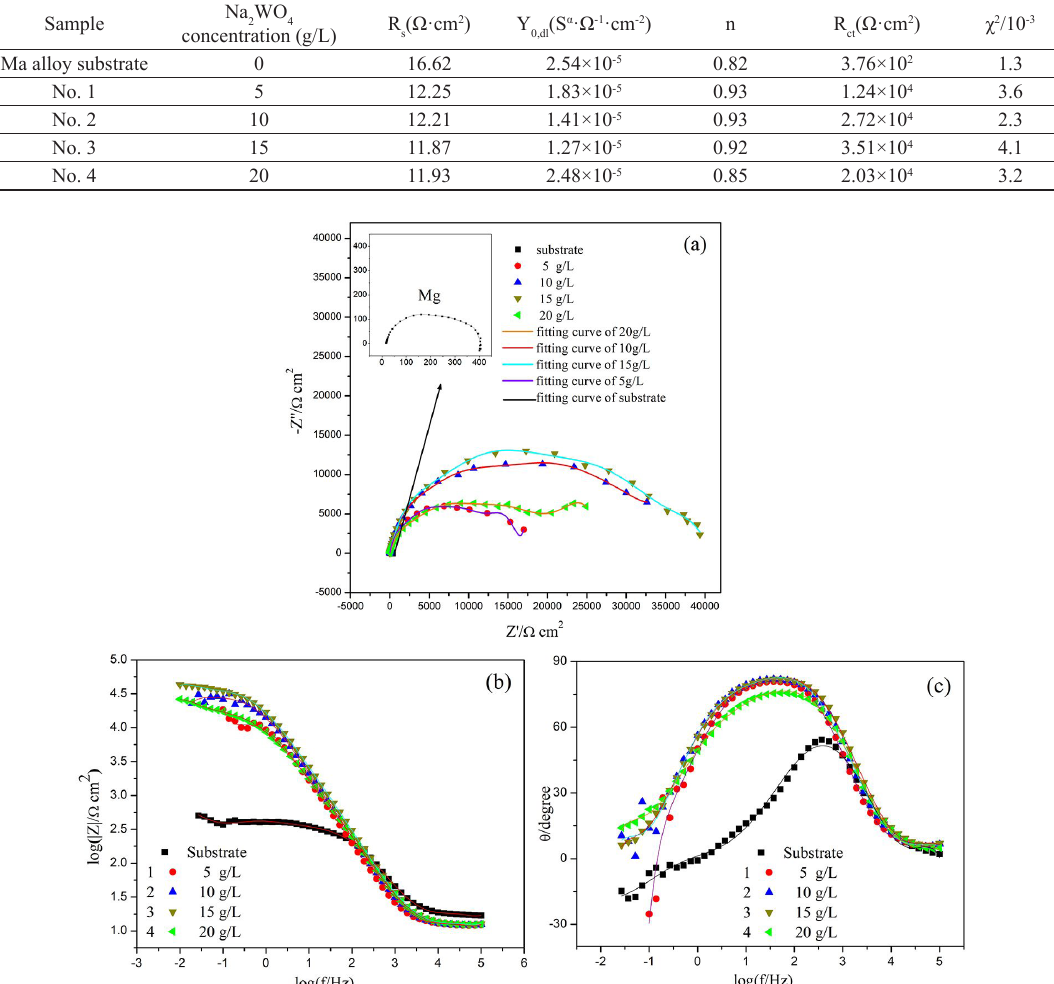
Figure 9. The impedance spectra of magnesium alloy and Ni-W-P coatings in 3.5 wt.% NaCl solution.